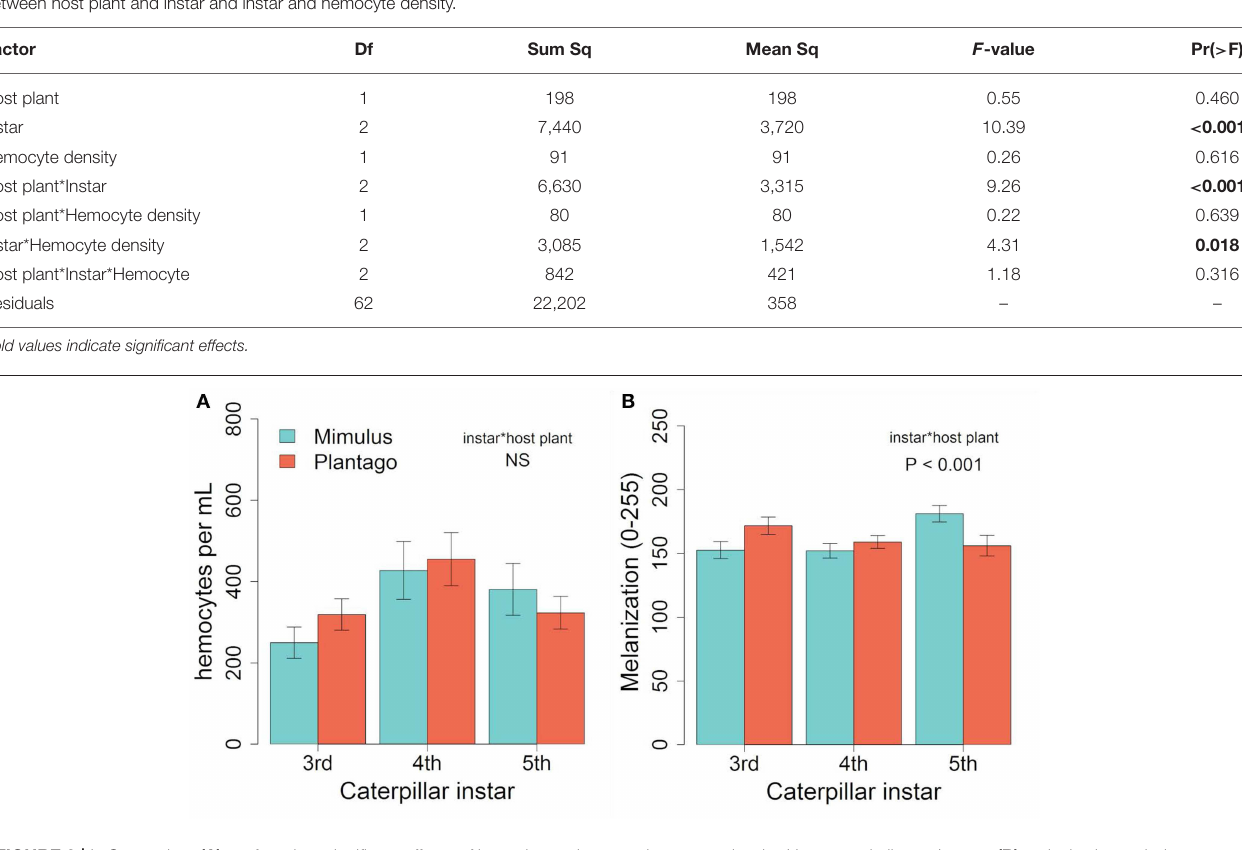
FIGURE 2 | In January, (A) hemocyte density varied by instar and was higher on Plantago though the interaction was not significant. (B) There was significant interaction between host plant and instar, suggesting melanization increased with instar when fed Mimulus but did not change when fed Plantago . (C) A significant interaction between instar and hemocyte density suggested that melanization increased with cell density in third and fourth instars, but decreased with increasing cell density in fifth instar caterpillars. Lines represent predicted linear relationships for each instar. Bars represent ± 1 SE. TABLE 1 | Results from ANCOVA in the January experiment included a main effect of caterpillar developmental instar on melanization, as well as interactions between host plant and instar and instar and hemocyte